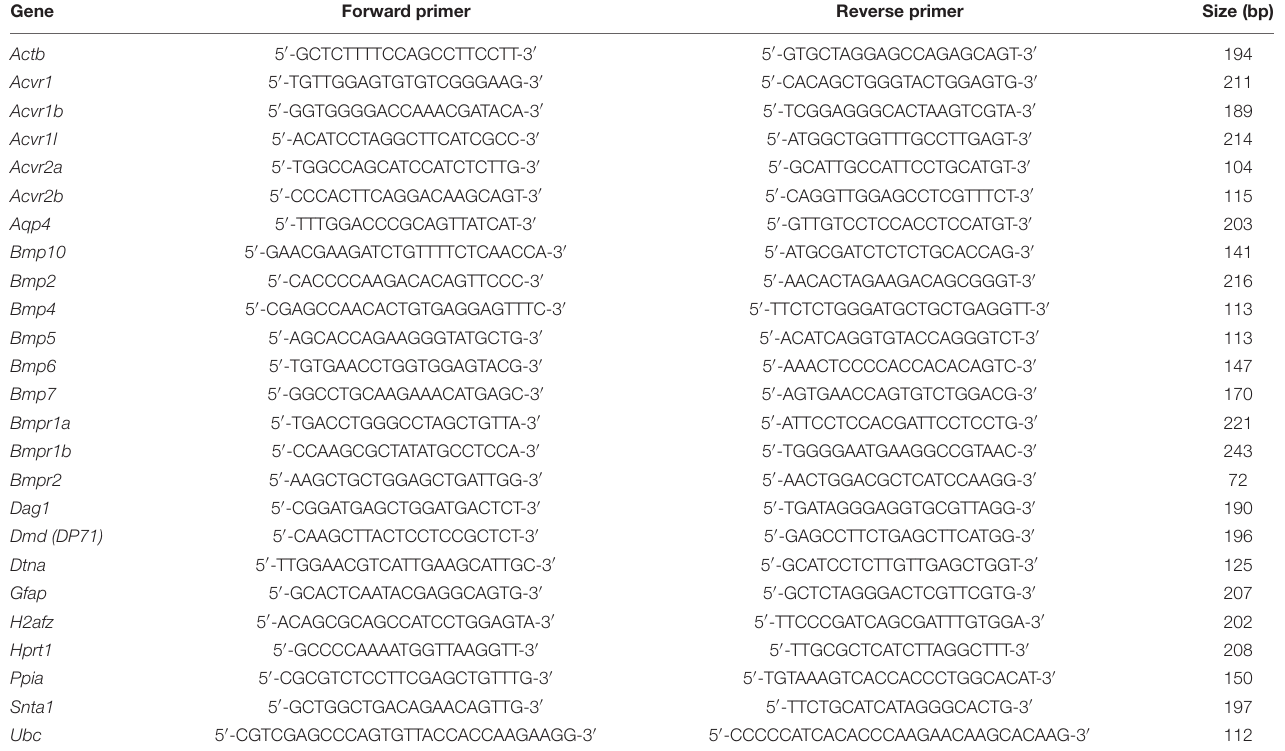
TABLE 2 | Primers used in RT-qPCR analysis. Gene Forward